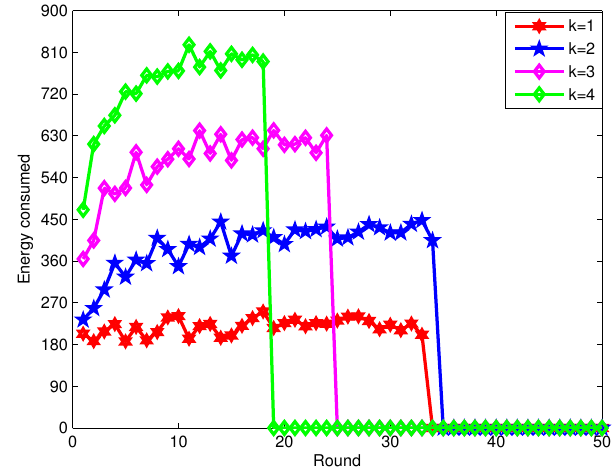
Figure 11. The energy consumed by all of the sensor nodes by the connected cover set in every